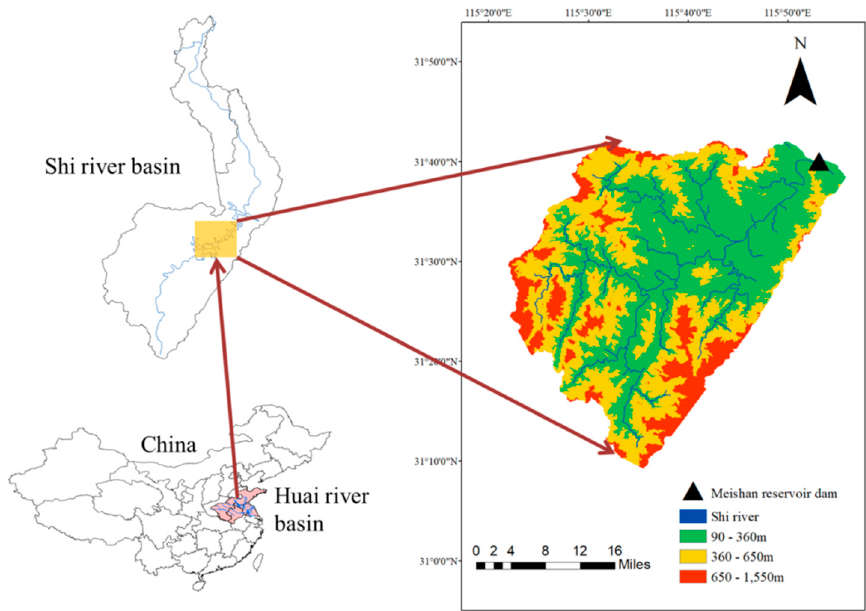
Figure 1. Location of the Meishan reservoir and its river basin.